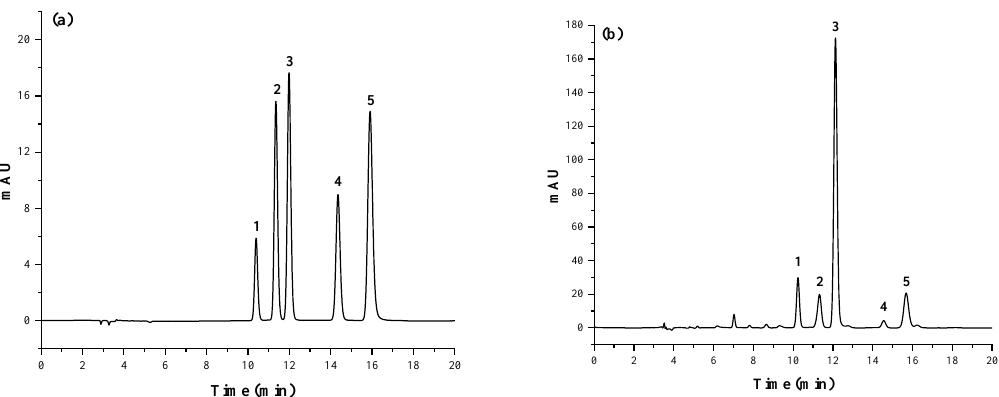
Figure 3. High-performance liquid chromatography (HPLC) profiles of four purine bases and uric acid at 254 nm. ( a ) Mixed standard working solution (5 mg/L); ( b ) Chinese chicken soup sample. Column: Agilent TC-C18 (2) (4.6 mm × 250 mm, 5.0 µm). Mobile phase: 0.2 M KH 2 PO 4 buffer solution, pH = 4. Flow rate: 1.0 mL/min. Column temperature: 30 °C, injection column: 10 µL. Peaks: 1, Uric acid; 2, Guanine; 3, Hypoxanthine; 4, Xanthine; 5, Adenine.